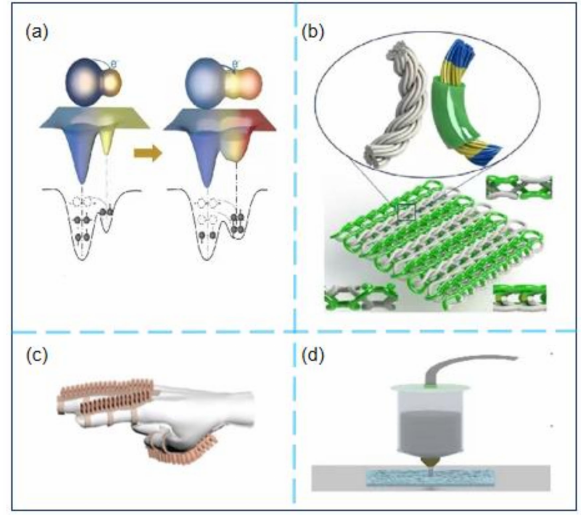
Figure 5. ( a ) Schematic illustration of an electron-cloud-potential-well model proposed to explain the charge transfer between spider silk and PET with/without PVDF (arrows indicate electron transfer events) [108]; ( b ) Schematic illustration of the fabrication process of the core-sheath yarn and 3DFIF-TENG[111]; ( c ) Schematic illustration of the assisting glove[114]; ( d ) Schematic illustration of the 4D Printed TENG[115]. ( a ) Reprinted with permission, LN: 5067420482614. ( b ) Reprinted with permission, LN: 5070100466333. ( c ) Reprinted with permission, LN: 5067550253136. ( d ) Reprinted with permission, LN: